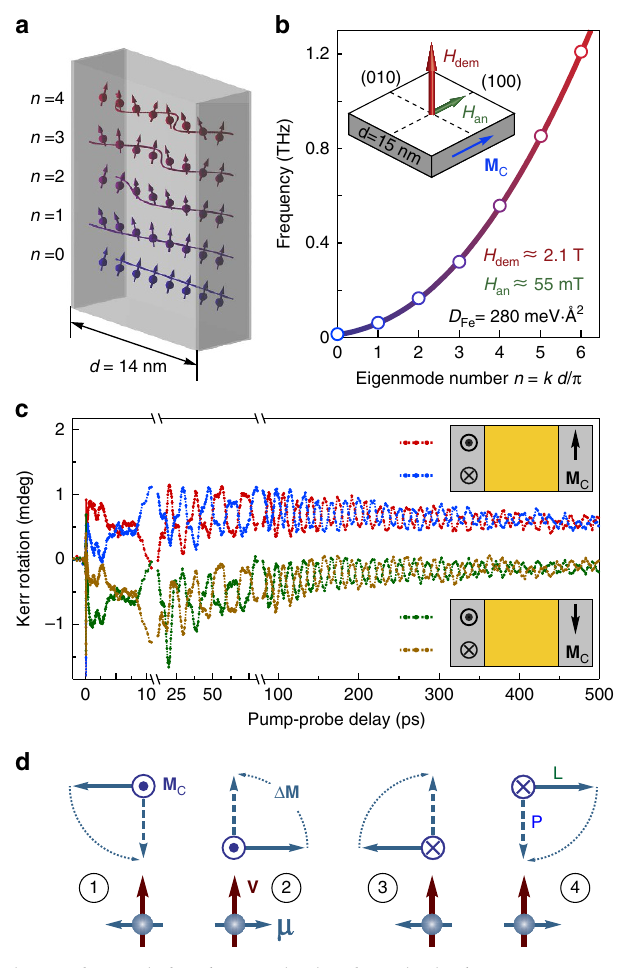
Figure 2 | Laser-induced magnetization dynamics in the Fe/Au/Fe/ MgO(001) multilayer. ( a , b ) Spin excitations in a thin Fe(001) film magnetized in-plane. The demagnetizing field H dem and the two in-plane easy axes with the effective crystalline anisotropy field H an result in the uniform magnetization precession with a frequency f 0 E 10GHz (ref. 29). A film with the thickness d and the exchange stiffness D Fe can sustain standing spin waves with a discrete set of eigenwavevectors k n ¼ p n / d and frequencies f n given by equation (2). ( c ) Time-resolved transient polar MOKE rotation obtained in four different geometries for orthogonal magnetizations of the emitter and collector. The periodic signals with multiple frequencies indicate the excitation of the standing spin-wave eigenmodes. ( d ) Separation of the longitudinal and polar MOKE contributions. Electrons in the SC pulse propagate with the velocity v and magnetic moment l . For the longitudinal SC polarization l and transverse magnetization of the collector M C , the solid (dashed) blue arrows depict the sign of the longitudinal, L (polar, P) transient magnetization component D M . The dotted lines illustrate the appearance of the polar component of M C due to the precession of